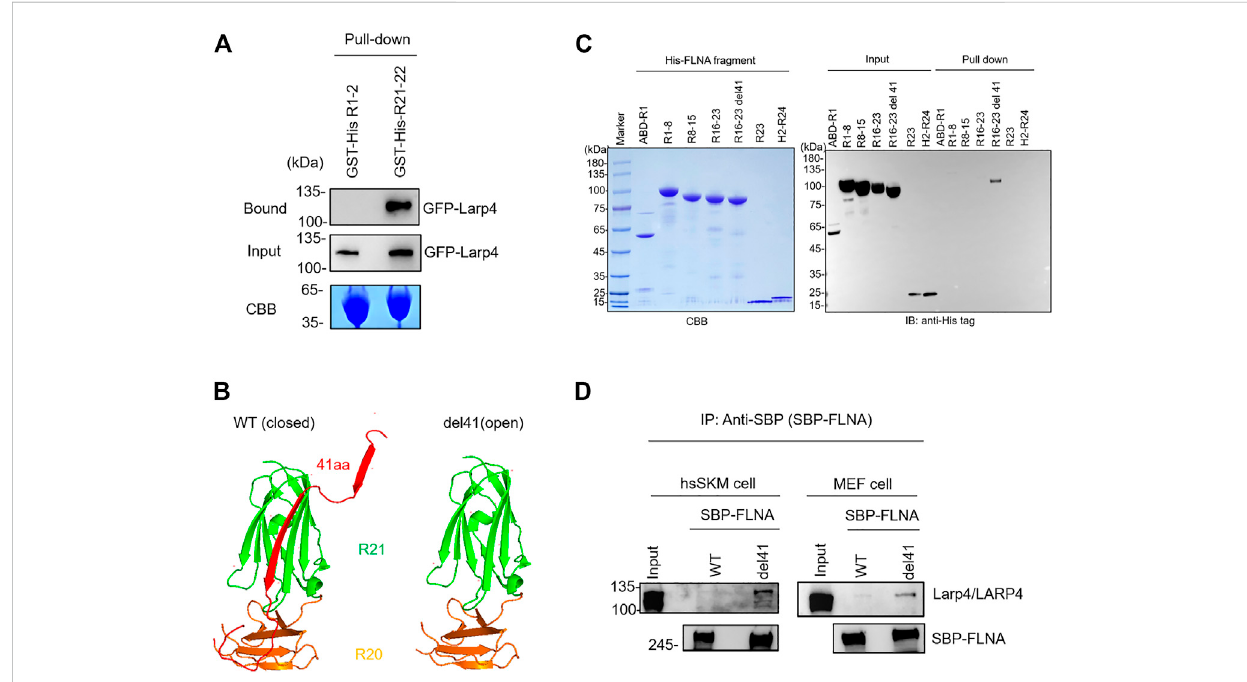
FIGURE 2 Selective interaction of LARP4 with open FLNA. (A) GFP-Larp4 was expressed in HEK 293A cells and the expressed protein was pulled down with puri fi ed GST-His-FLNA fragments. CBB staining showed 5 μ g of the puri fi ed GST fusion protein loaded to the 9% SDS-PAGE gel. Bound GFP-Larp4 was detected by western blotting using rabbit anti-GFP antibodies. (B) The CD face of R21 is blocked with strand A of R20 in WT FLNA (left). Deletion of 41 amino acid residues (del41) constitutively exposes the cryptic binding site (right). (C) Mapping of Larp4-binding site on FLNA. Puri fi ed His-tagged FLNA fragments were pulled down with GST-Larp4 immobilized on glutathione beads. CBB staining showed 2 μ g of the puri fi ed His-tagged FLNA fragmentsproteinloadedtothe4% – 12%SDS-PAGEgel.Thelowerbandsoftheinputproteinsareindicativeofdegradationduringexpressioninbacteria. Black arrow indicates the GST-Larp4. Bound His-tag FLNA fragments were detected by western blotting using anti-His-tag antibody. (D) SBP-FLNA (WT and del41) was expressed in HEK293A cells and immobilized on streptavidin-beads. The beads were incubated with lysates of hsSKM (left) or MEF (right) cell and bound Larp4/LARP4 was detected by western blotting using anti-LARP4 antibodies. CBB: Coomassie Brilliant Blue. IB: Immunoblot. IP: